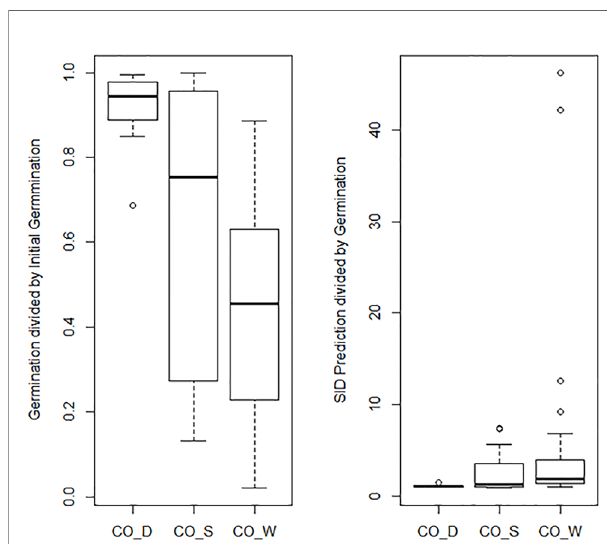
FIGURE 4 | The graph to the left shows a boxplot of the fi nal germination as proportion of initial germination for the three cold storage studies: Desheva (2016): CO_D; Stanwood (see Walters et al., 2005): CO_S, Walters et al. (2005): CO_W; Roos and Davidson (1992): CO_R. The graph to the right shows a boxplot of predicted fi nal germination as proportion of observed fi nal germination in the same three studies. The predicted values are extracted from the Seed Information Database (RBG Kew,